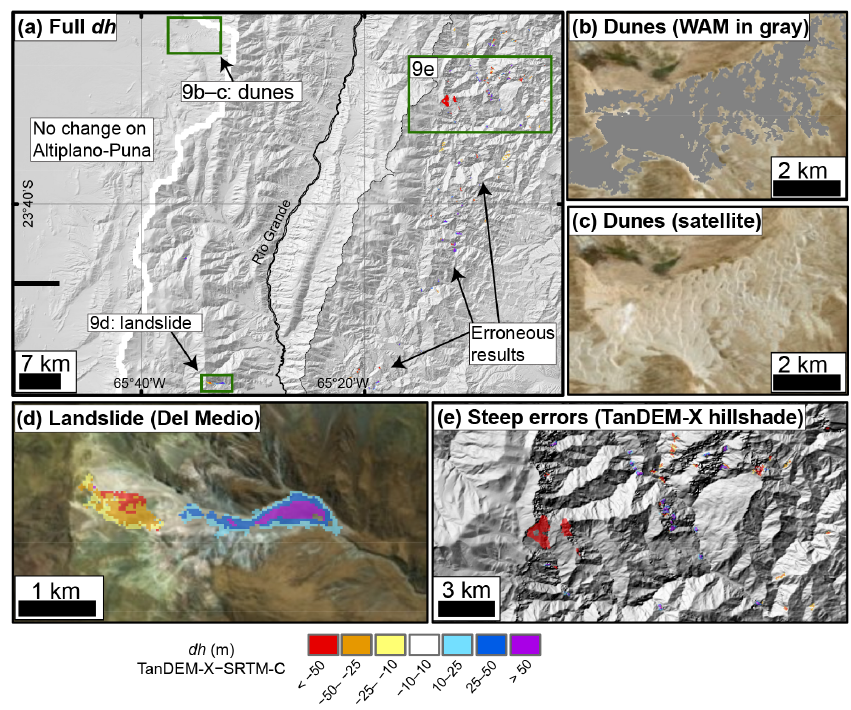
Figure 9. (a) Map view of landscape-wide dh identification. For location refer to Fig. 1c. Our method returns little change on the low-erosion Altiplano–Puna. The dunes (b – c) are not identified since they are masked out using the TanDEM-X auxiliary WAM as low-coherence zones. This indicates their rapid displacement between the TerraSAR-X and TanDEM-X scene collection. Our method is able to identify one major landslide (d) in the Del Medio catchment (Savi et al., 2016); however, there are many erroneous results in steep and vegetated zones to the east, shown in (e) over the TanDEM-X